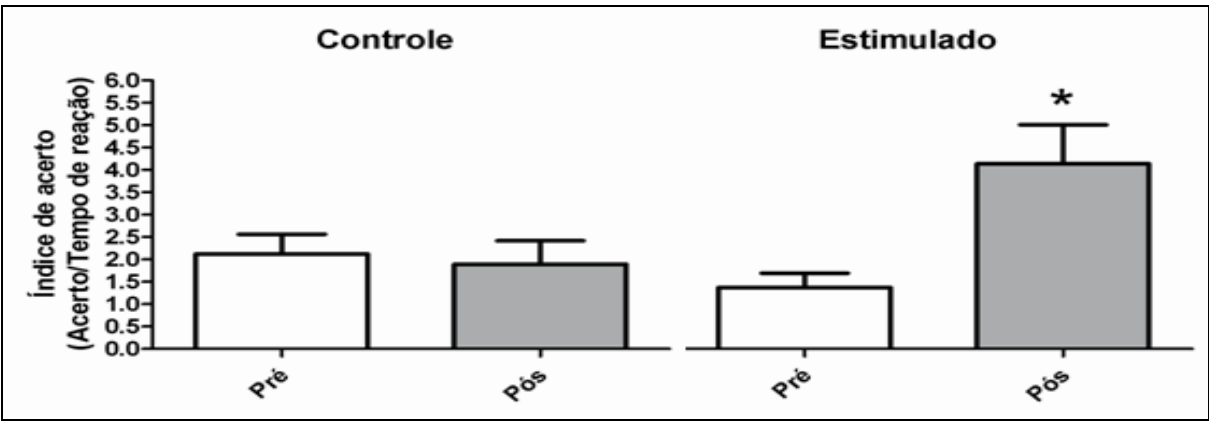
Figura 6. Índice de acerto (Acerto/Tempo de reação). A figura ilustra a divisão entre o índice médio de acerto que é obtido pelo tempo de reação nos grupos experimental e controle no momento pré e pós estimulação cortical. Verifica-se o índice do grupo controle (à esquerda) e do grupo estimulado (a direita) no momento pré e pós o treinamento. (*) Indica diferença após o treinamento no momento pré e pós sendo p<0.05. Dados expostos na forma de média +